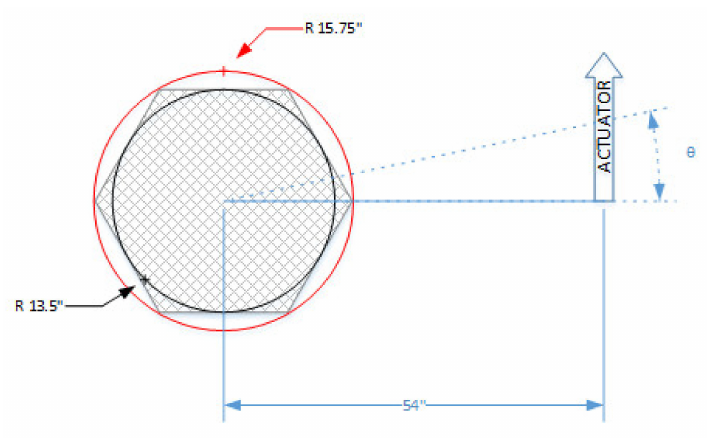
Figure 10. Schematic drawing of “SR3” shear testing.